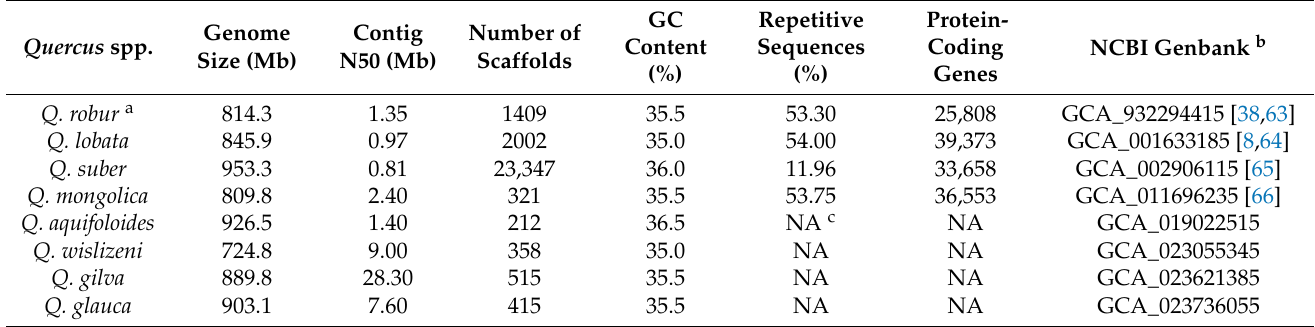
Table 2. Assembly statistics of the whole-genome sequencing of Quercus